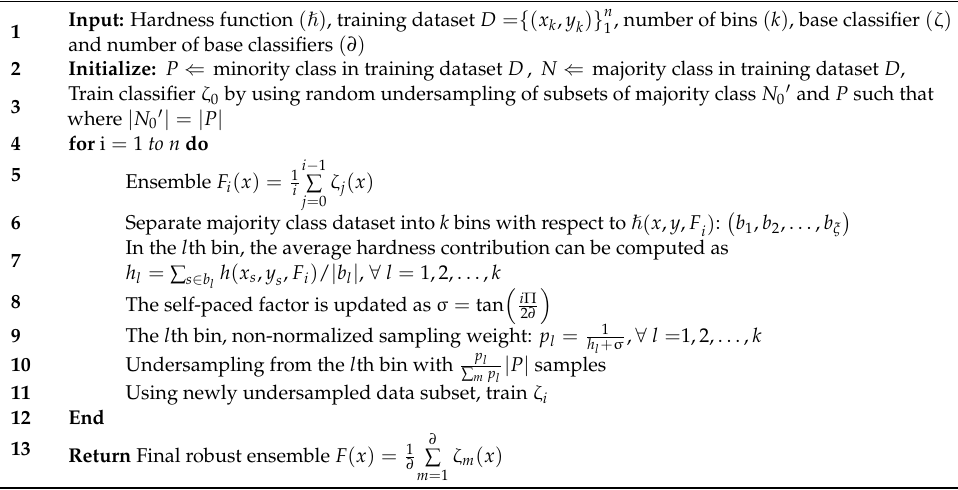
Algorithm 1: Self-Paced Ensemble (SPE)